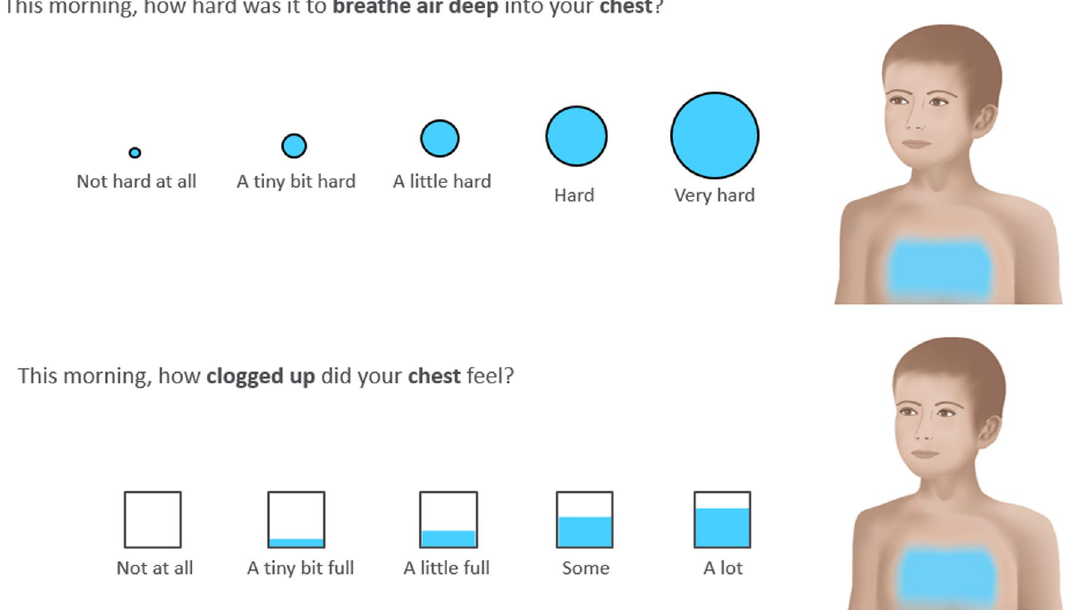
Fig. 2 Chest related ePRO example items and response